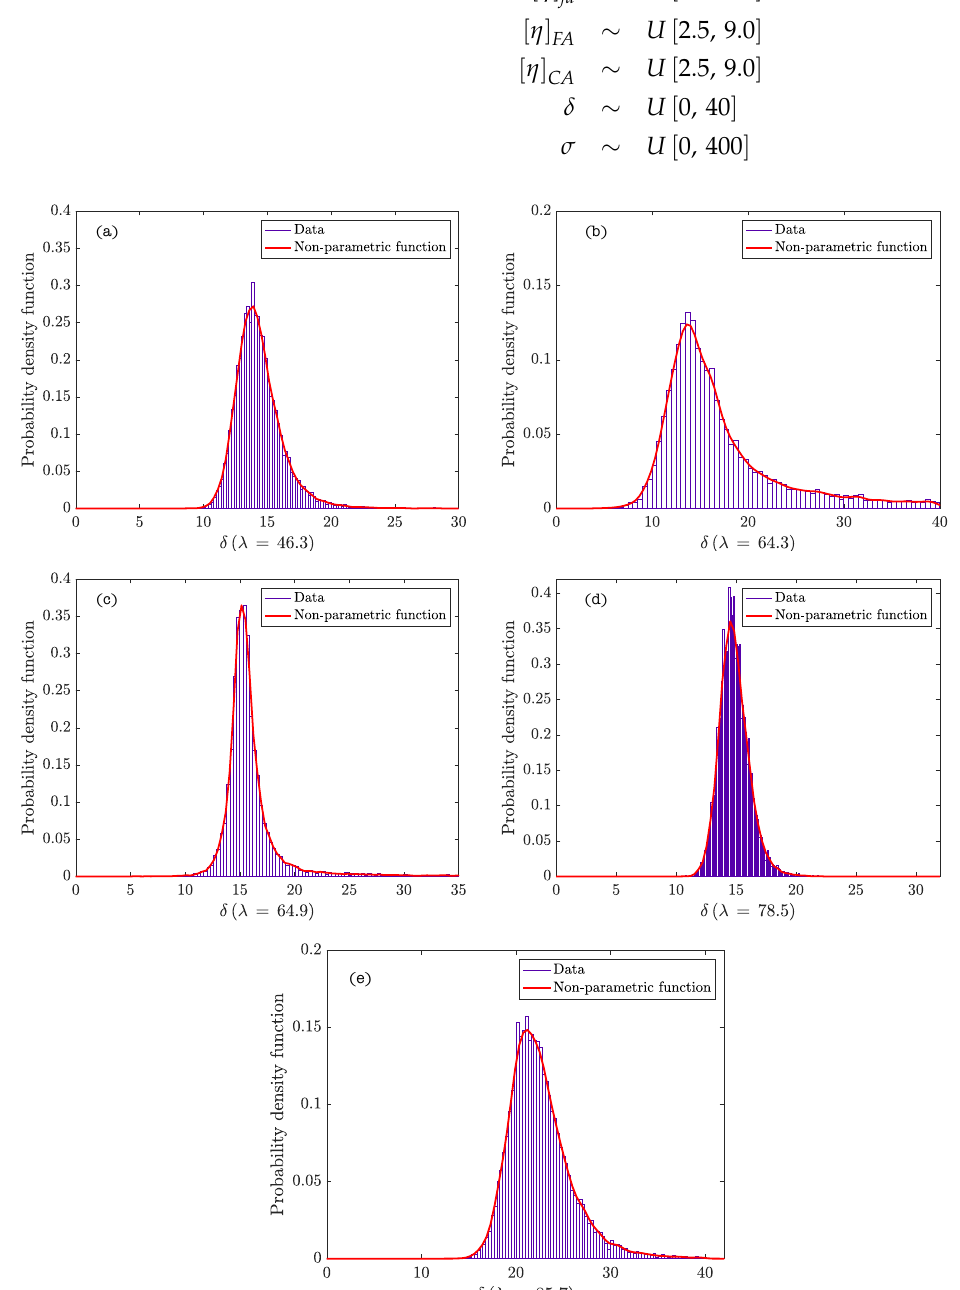
Figure 1. Probability density functions of δ for different values of λ ( λ =46.3 ( a ), 64.3 ( b ), 64.9 ( c ), 78.5 ( d ), and 85.7 ( e